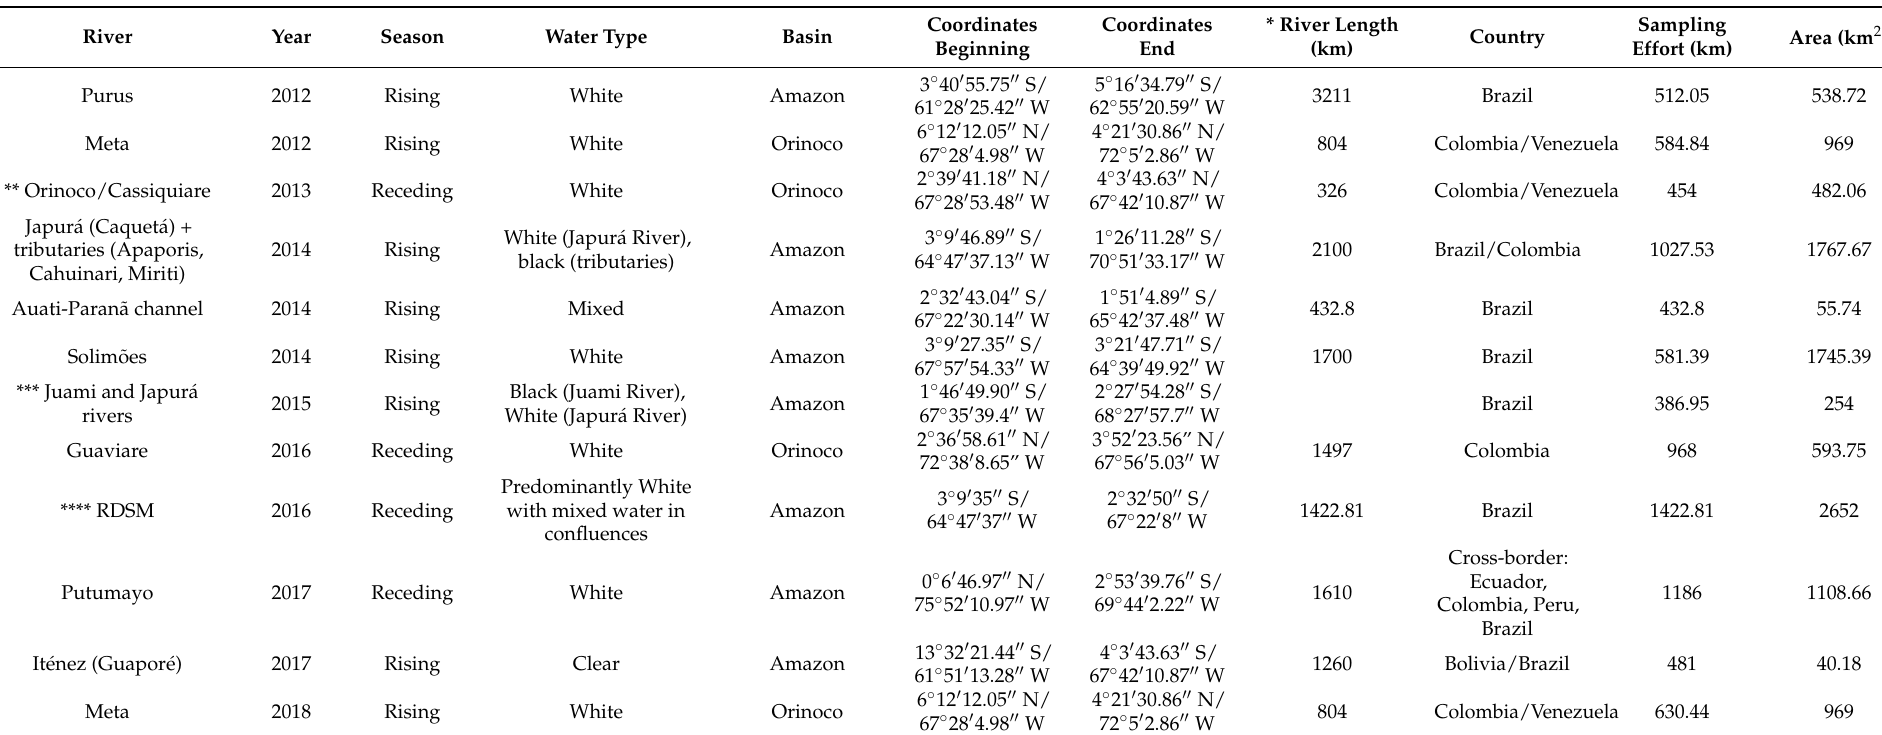
Table 1. Sampling effort and study areas of South American river dolphins (boto and tucuxi) abundance estimates in the Amazon and Orinoco basins, following chronological order of sampling effort from 2012 to